Question: Write a single sentence explaining what this figure depicts.
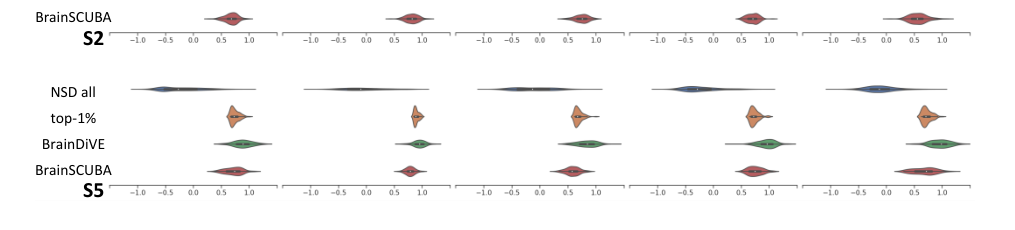
Answer: Evaluating the distribution of BrainSCUBA captions with a different encoder. We train an encoder with a different backbone (EVA02-CLIP-B-16) from both BrainDiVE and BrainSCUBA. For each region, we evaluate the response to all images a subject saw in NSD, the response of the top-1% of images in NSD stimuli ranked using EVA02, the top-10% of images generated by BrainDiVE and BrainSCUBA and ranked by their respective encoders. Each region is normalized to [−1, 1] using the min/max of the predicted responses to NSD stimuli. BrainSCUBA can achieve high predicted responses despite not performing explicit gradient based maximization like BrainDiVE, and yields concretely interpretable captions. BrainSCUBA is also ∼10× faster per image.